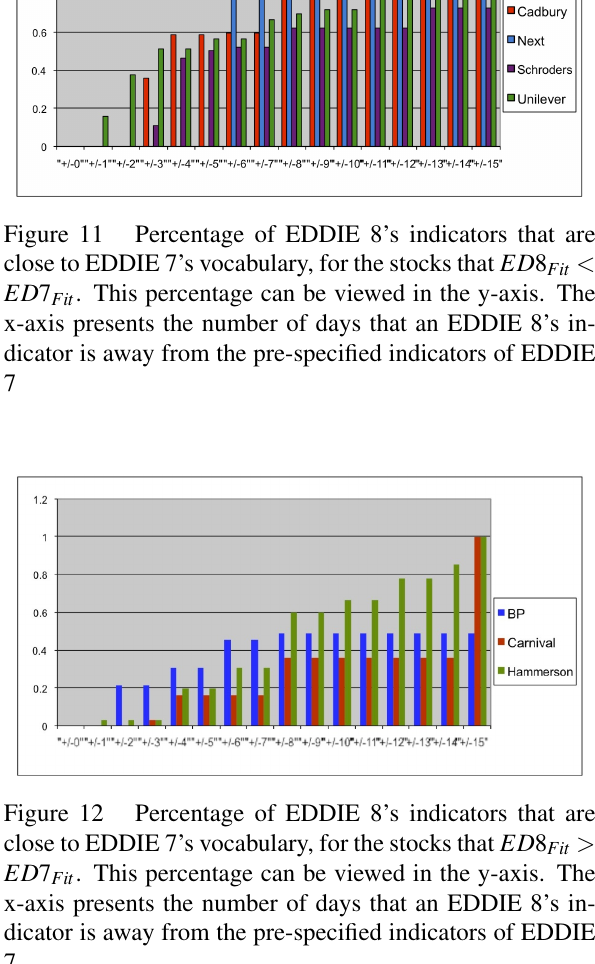
indicators for these 4 stocks are close to indicators from EDDIE 7’s grammar, in a range of [-4,+4] days; this percentage